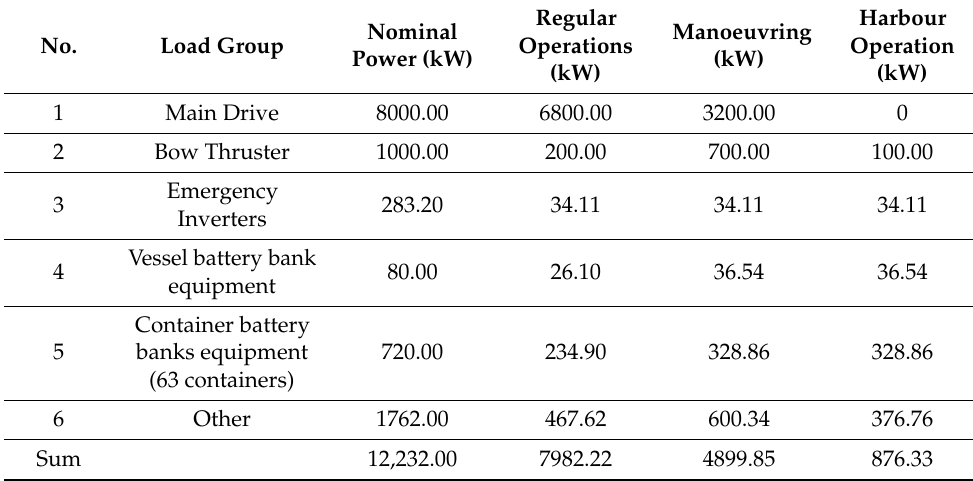
Table 1. Onboard load groups parameters.